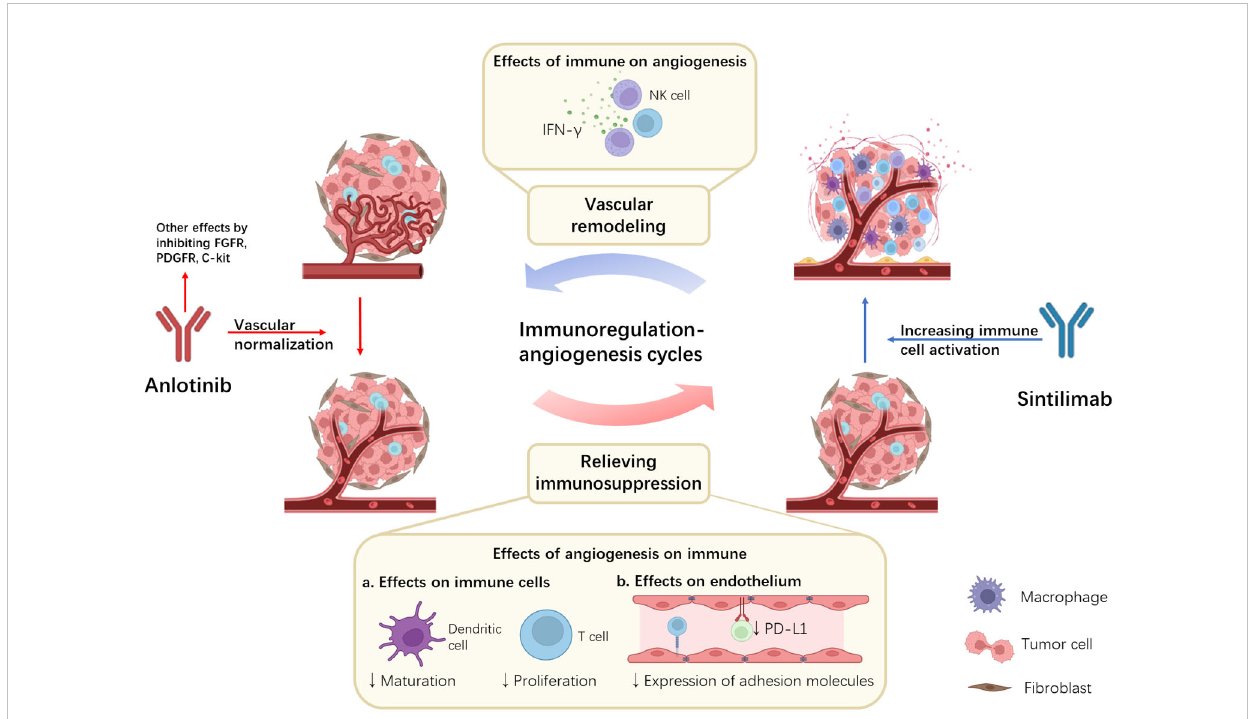
FIGURE 2 Potential synergistic mechanisms of Anlotinib combined with Sintilimab and the immunoregulation-angiogenesis cycles. Anlotinib inhibits angiogenesis by targeting VEGF. At the same time, the inhibition of VEGF can also relieve immunosuppression in the tumor microenvironment by directly affecting immune cells and indirectly affecting endothelium. Sintilimab binds to PD-1 and blocks its binding to PD-L1 and PD-L2, activating immune cells. At the same time, activated immune cells release large amounts of IFN- g , further leading to vascular remodeling. Positive feedback is formed between immune regulation and